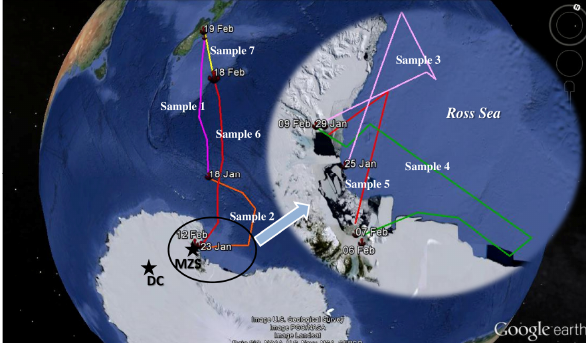
Figure 1. The sampling sites: the Italian base “Mario Zucchelli Sta- tion” (MZS) (74 ◦ 42 (cid:48) S–164 ◦ 06 (cid:48) E), the Italian–French base “Con- cordia Station” (Dome C) (75 ◦ 06 (cid:48) S–123 ◦ 20 (cid:48) E) and the track chart of the R/V Italica